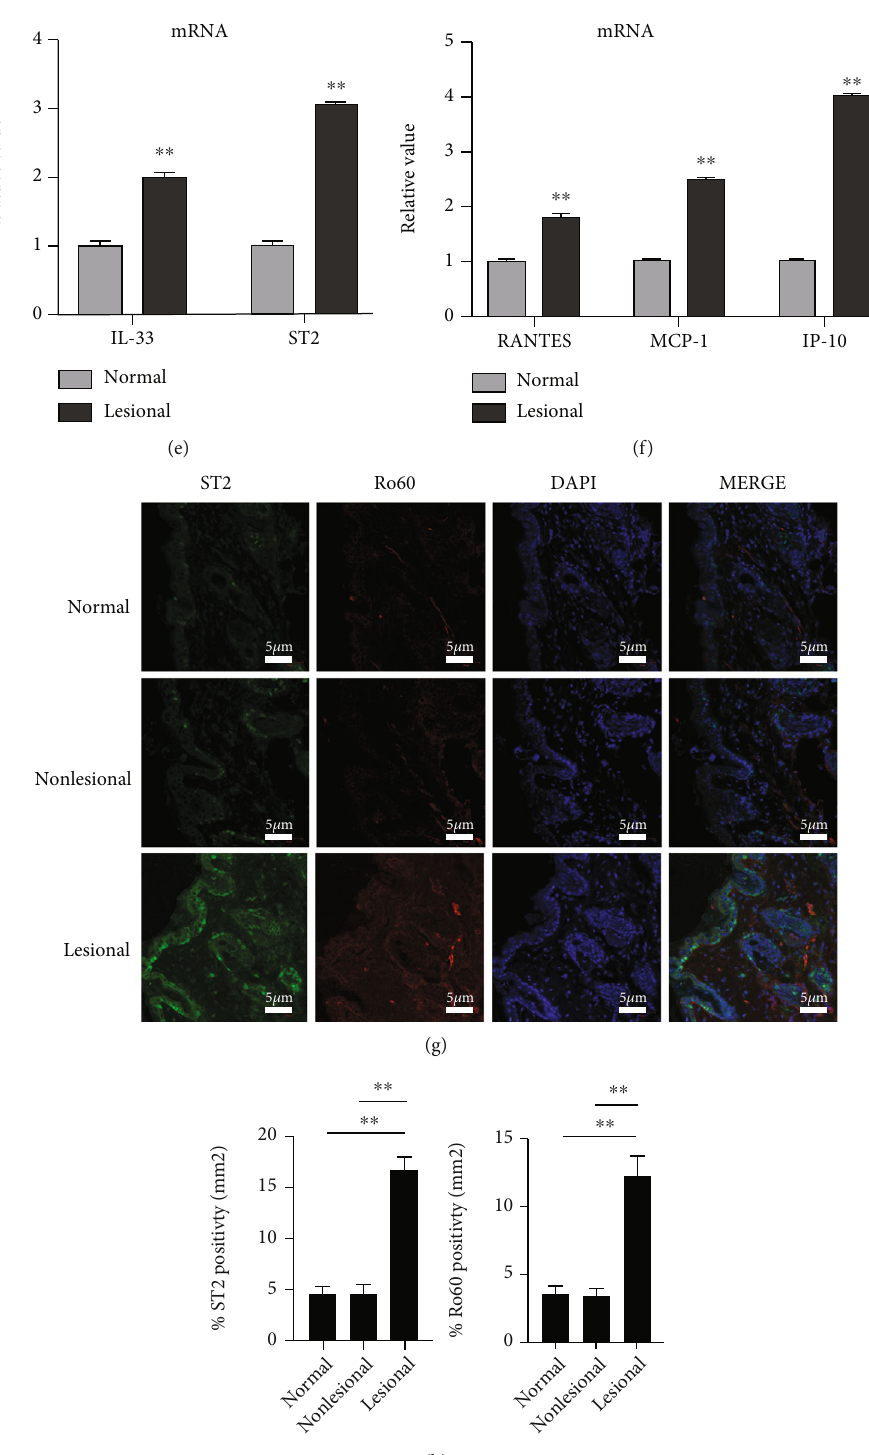
Figure 1: IL-33 and ST2 are upregulated in CLE patients ’ cutaneous lesions. (a) Immuno fl uorescence analysis of IL-33 in para ffi n sections. (b) Numerical quanti fi cation of the positivity percentage per square millimeter of IL-33-stained sections. (c) Immuno fl uorescence analysis of ST2 in para ffi n sections. (d) Numerical quanti fi cation of the positivity percentage per square millimeter of ST2-stained sections. (e) qRT- PCR analysis of IL-33 and ST2 mRNA expression in fresh skin tissues. (f) qRT-PCR analysis of RANTES, MCP-1, and IP-10 mRNA in fresh skin tissues. (g, h) Immuno fl uorescence analysis of Ro60 colocalization and ST2 expression in lesional skin tissues. Normal samples ( n = 10 ), nonlesional samples ( n = 15 ), and lesional samples( n = 15 ). Data points and error bars represent mean ± SEM . Representative images are shown. Bar = 50 μ m . ∗ p < 0 : 05 , ∗∗ p < 0 : 01 . CLE: cutaneous lupus